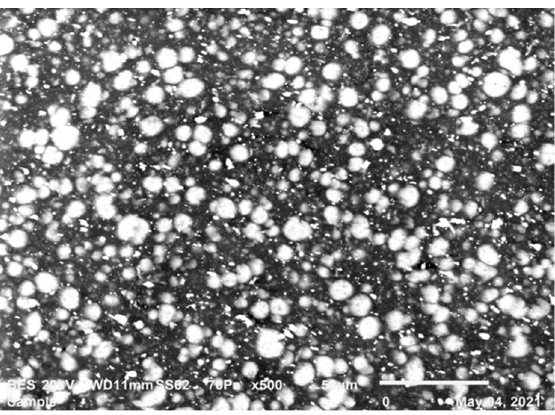
different regions in the zone ( a ).